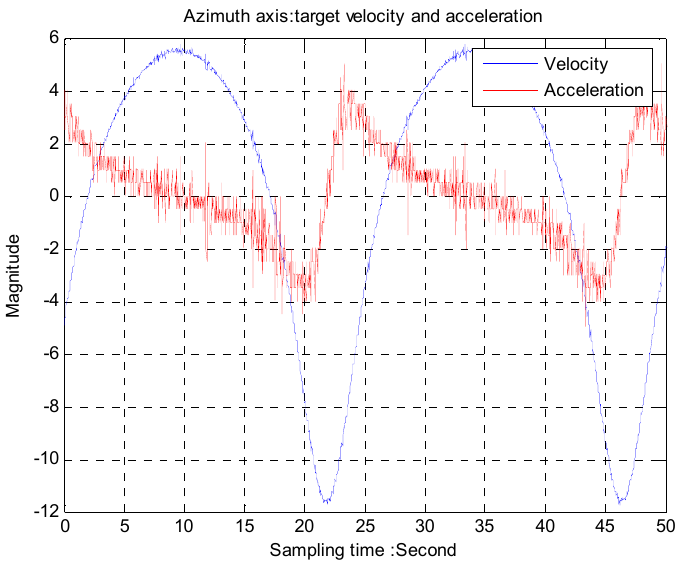
Figure 9. Azimuth axis: target velocity and acceleration.